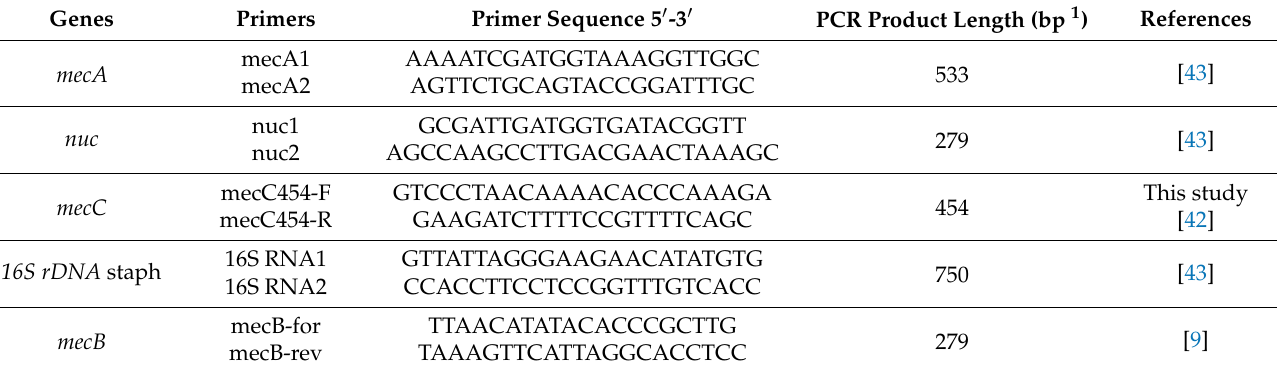
Table 3. Primers used for the mecA/nuc , mecC/16S rDNA staph and mecB gene detection by PCR.